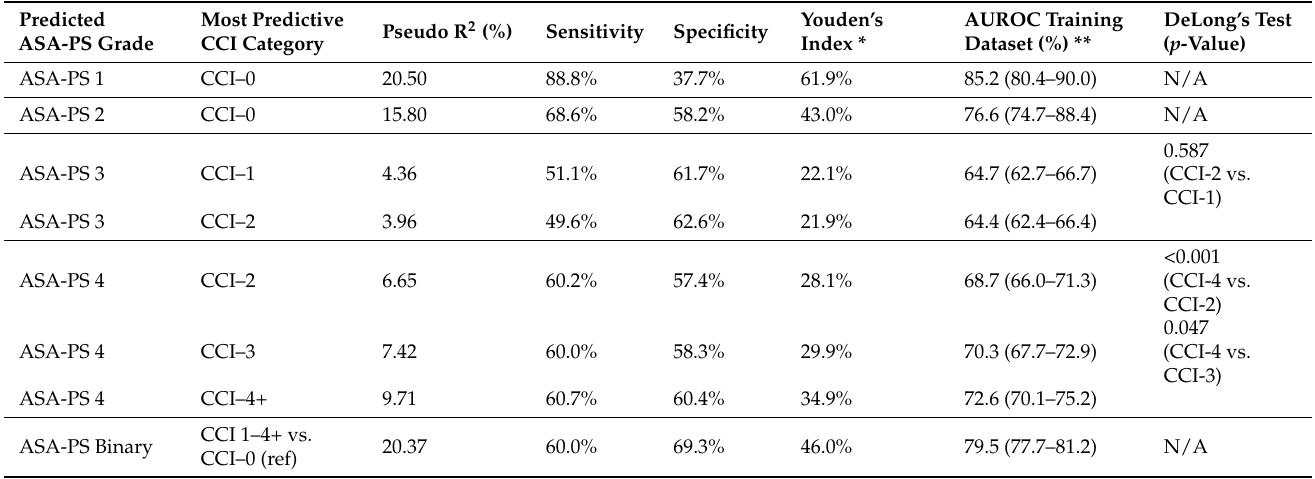
Table 4. Summary of the discriminant properties of the most predictive CCI value and each ASA-PS